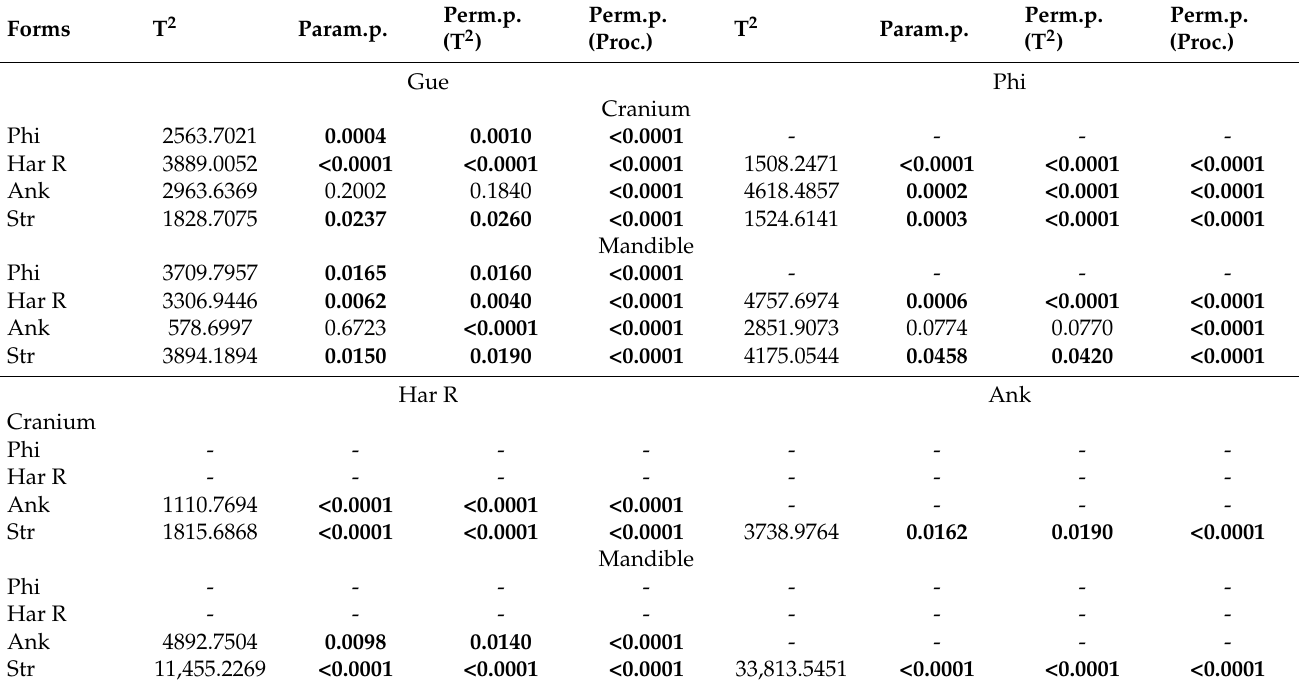
Table 7. DFA results for cranial and mandibular specimens among five vole forms of the “guentheri” group (T 2 : T-square, Param. P: parametric p values, Perm. P: permutation p value, Proc.: Procrustes distance, boldfaced: a significant difference).